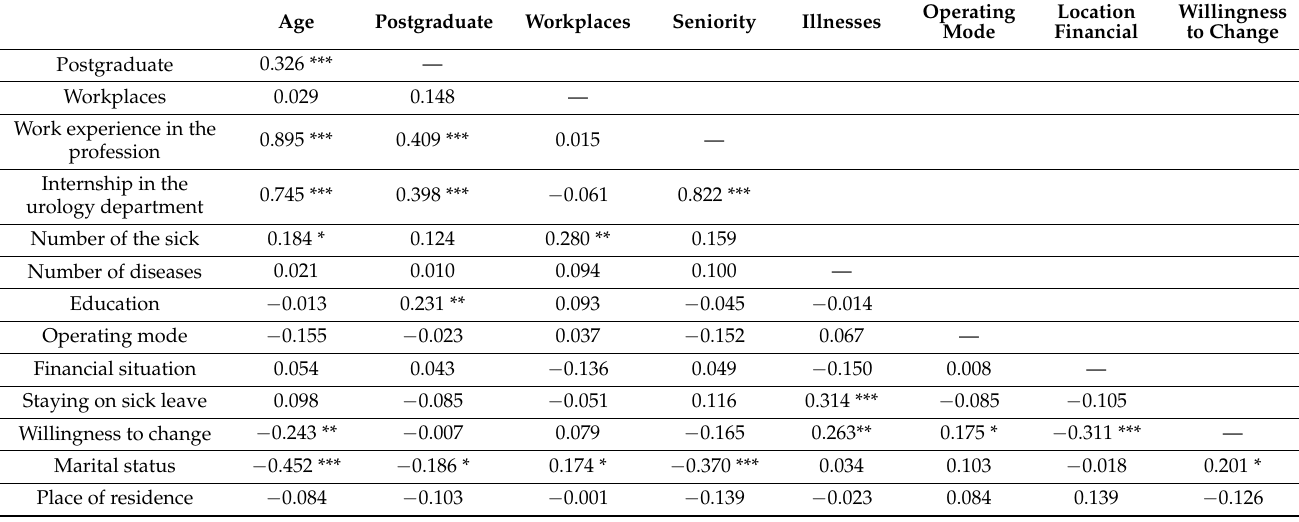
Table 3. Correlation analysis of independent variables